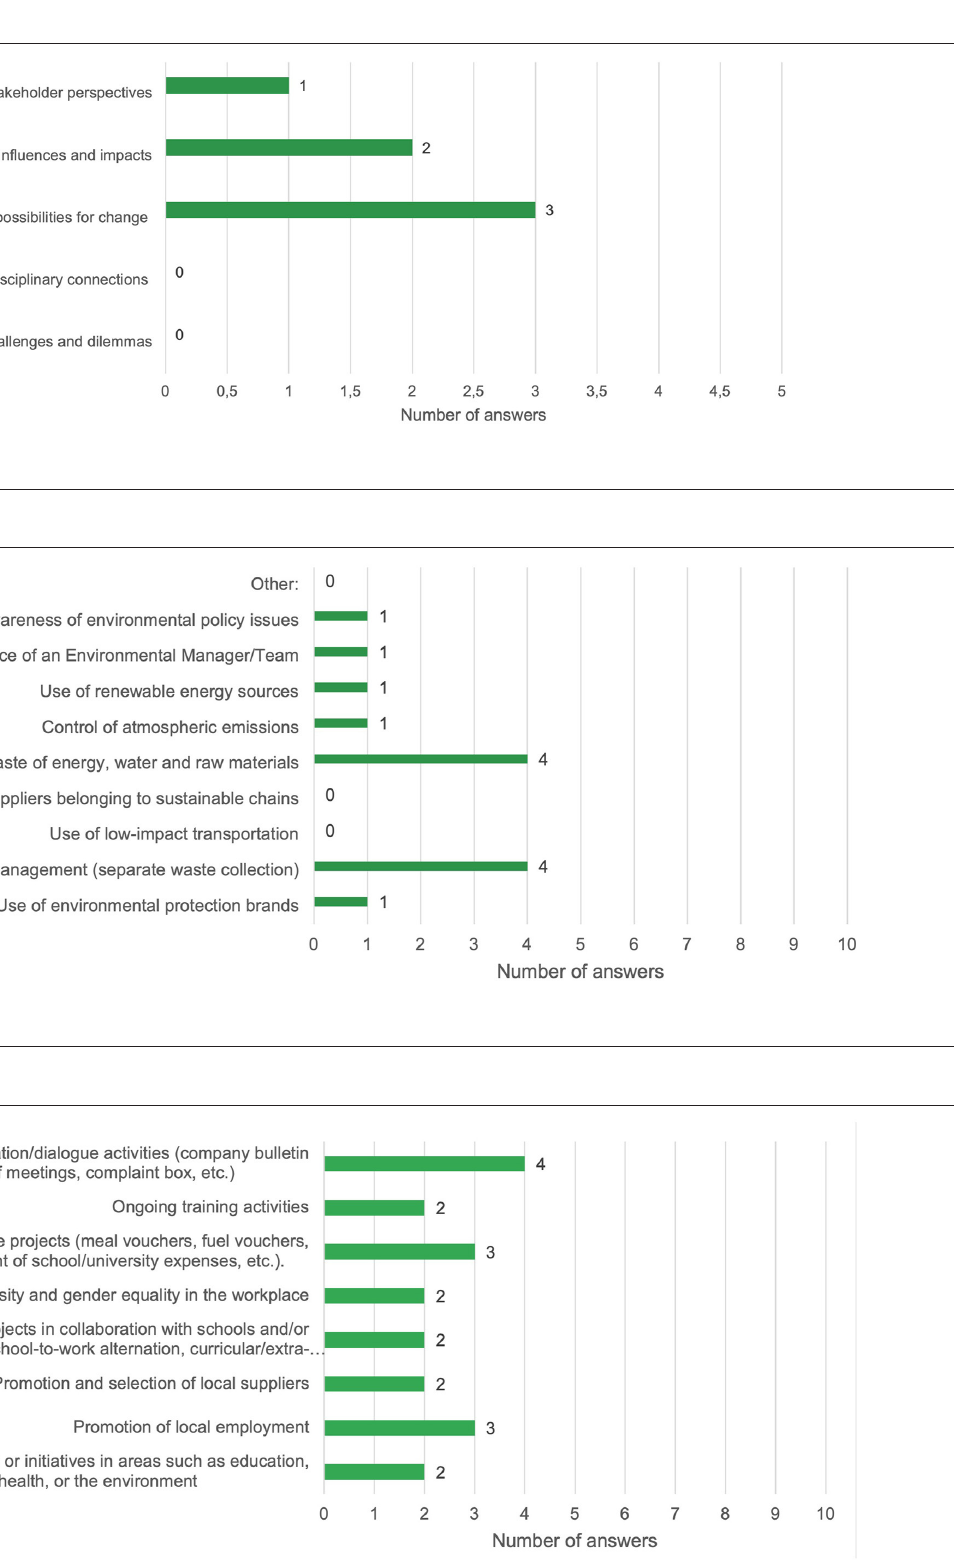
FIGURE 8 | Social